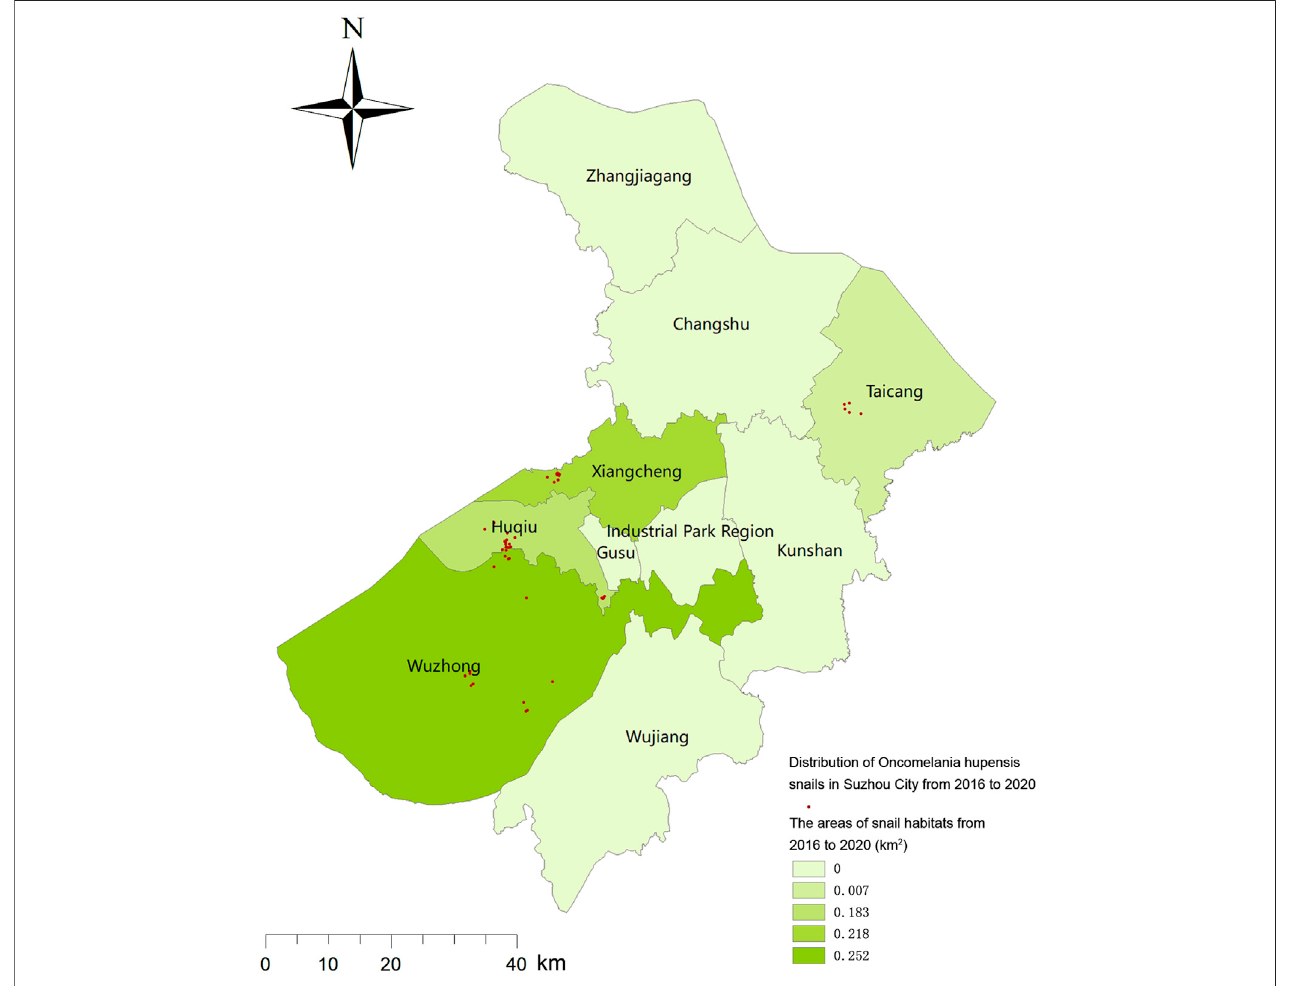
FIGURE 1 | Distribution of Oncomelania hupensis in Suzhou City from 2016 to